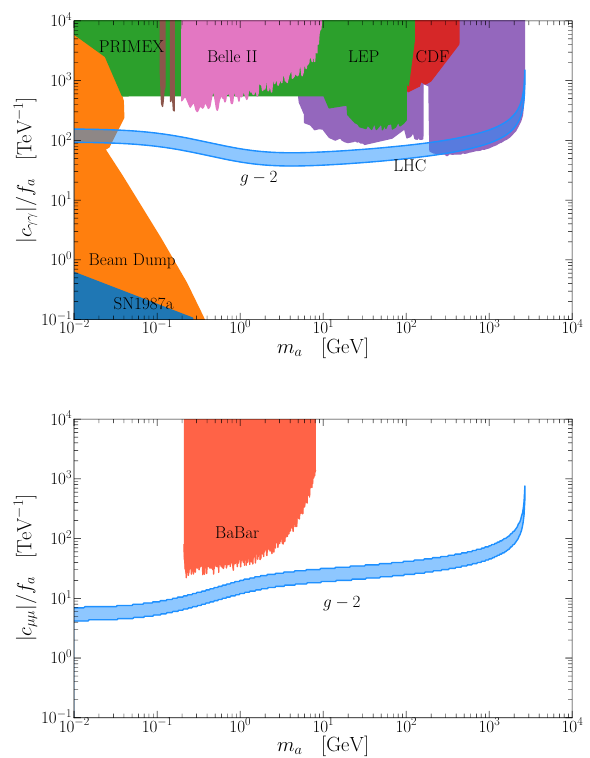
Figure 3 . Top: minimal c γγ /f a needed to explain the muon g − 2 anomaly as a function of m a (upper blue band), varying c . The other colored regions are the current experimental constraints, µµ taken from figure 29 of ref. [22], as well as the recent bounds from PRIMEX [40] and Belle II [41]. Note that for the LHC bound, which comes from a → γγ channel, we need to take into account the contribution of the axion-muon coupling to both the production of axions and their branching fraction into photons. Bottom: corresponding c when c is minimized. The BaBar con- µµ /f a γγ /f a straint is a recast of their e + e − → µ + µ − Z 0 bound in [42] using FeynRules [43] and MadGraph [44], assuming the given c and (for the purposes of obtaining a branching fraction) the minimal c µµ γγ needed to explain the muon g − 2 anomaly. In practice, the muonic branching fraction is nearly 100% in the entire excluded region. In both panels, we take Λ = 1